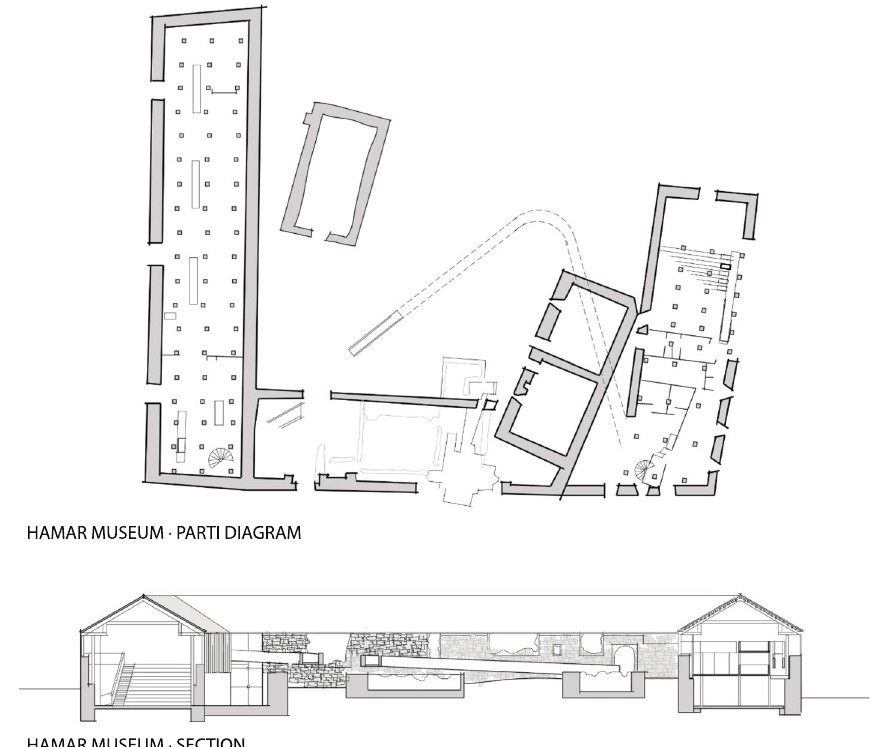
Fig. 9 Hedmark Museum, Hamar, Norway, 1967–2005. Above: Plan. Below: building section (Source: the